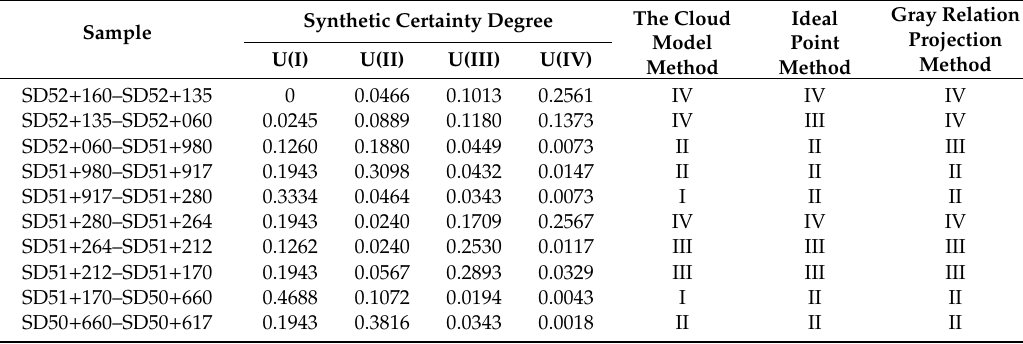
Table 8. Calculation results of the di ff erent evaluation methods applied to the SS (Shuang-san)